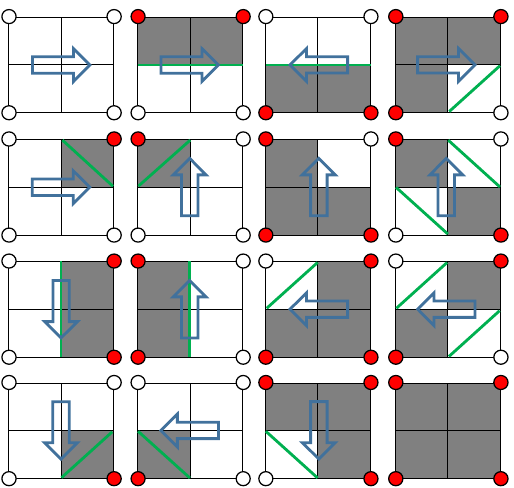
Figure 4. Search direction and slice contour.